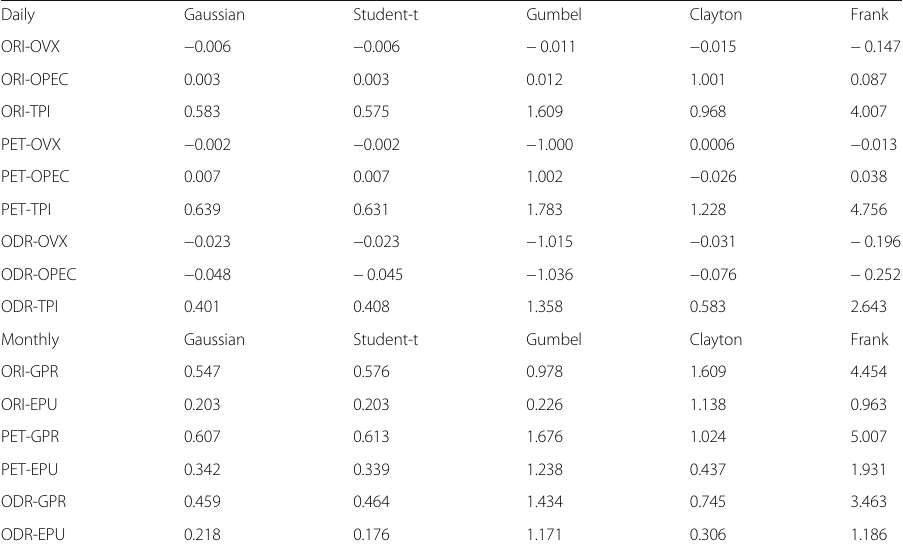
Table 6 The estimated copula dependence parameters for Gaussian, Student-t, Gumbel, Clayton, and Frank copula models Daily Gaussian Student-t Gumbel